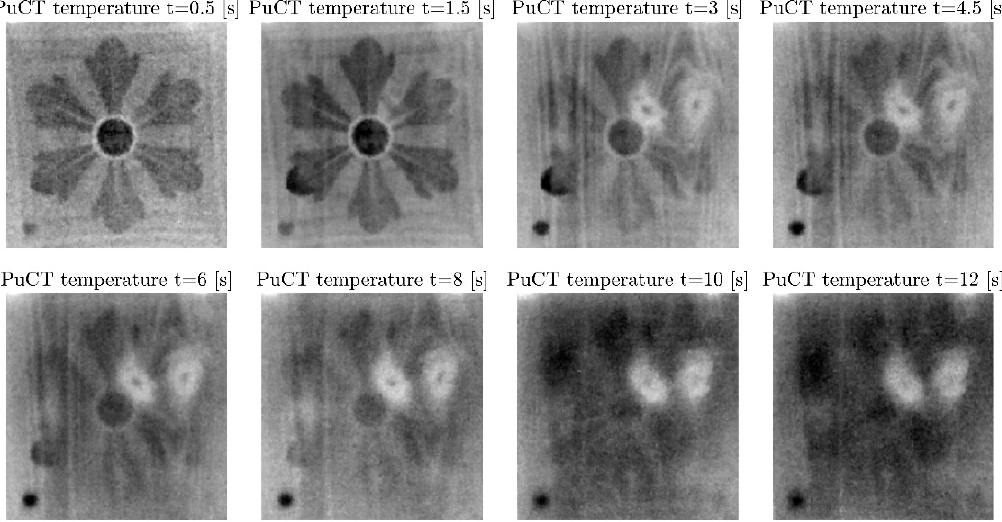
Figure 8. Selected thermograms obtained after PuCT applied to experimental data collected with Xenics Onca-MWIR-InSb, i.e., setup (b).